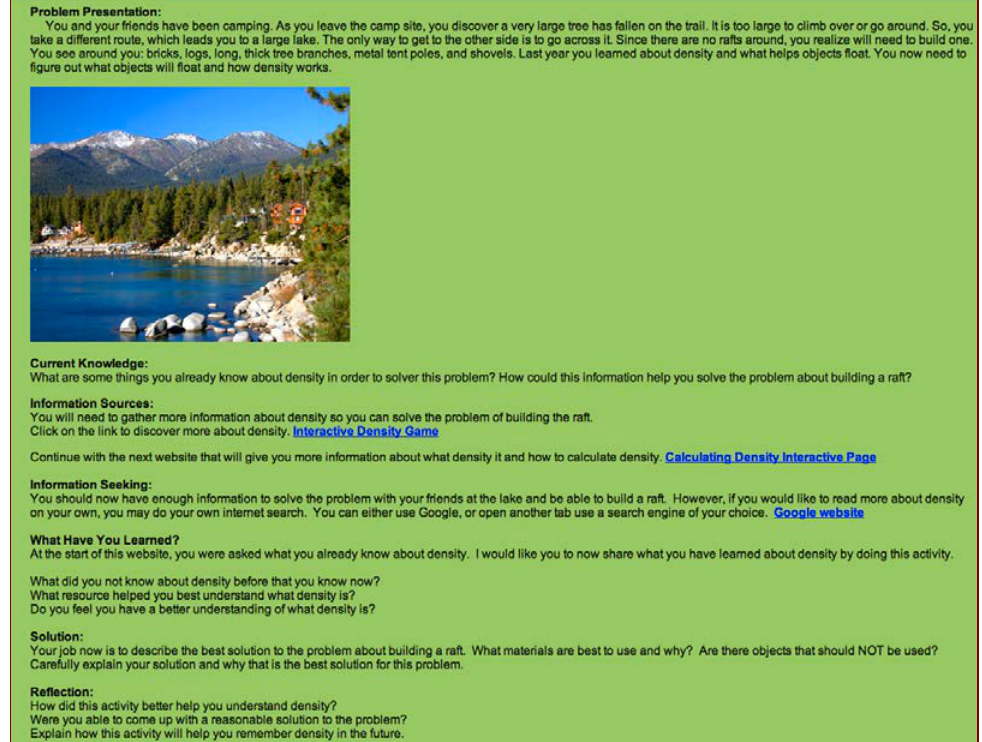
Figure 1. Example of an inquiry-based IA project.